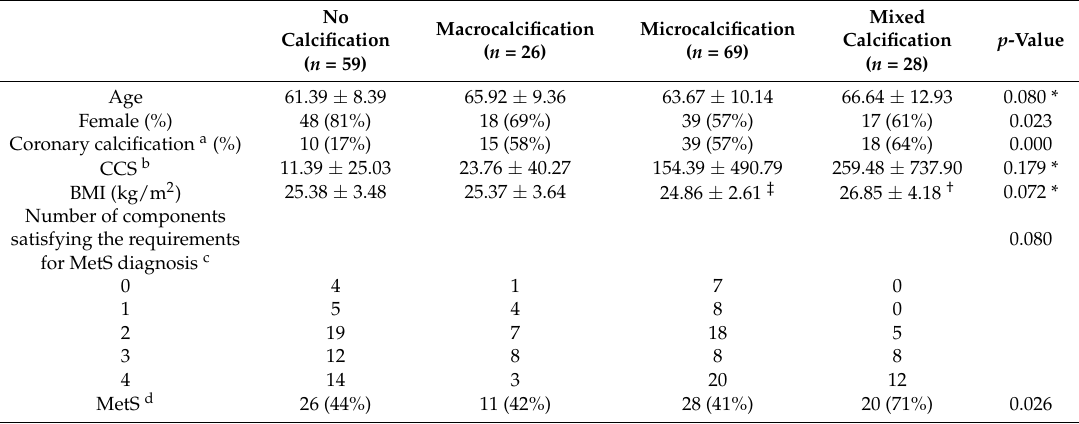
Table 1. Relationship between four papillary thyroid carcinoma (PTC) calcification patterns and coronary artery calcification / metabolic parameters (Group 1).